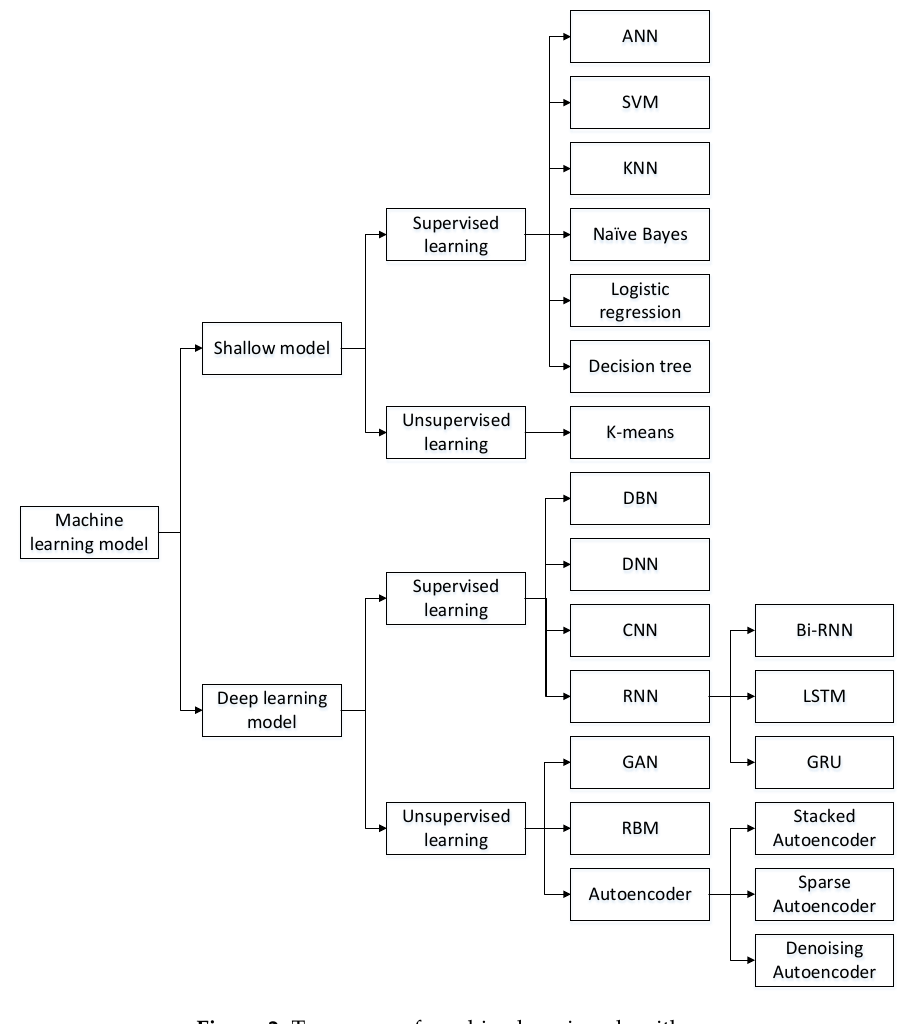
Figure 2. Taxonomy of machine learning